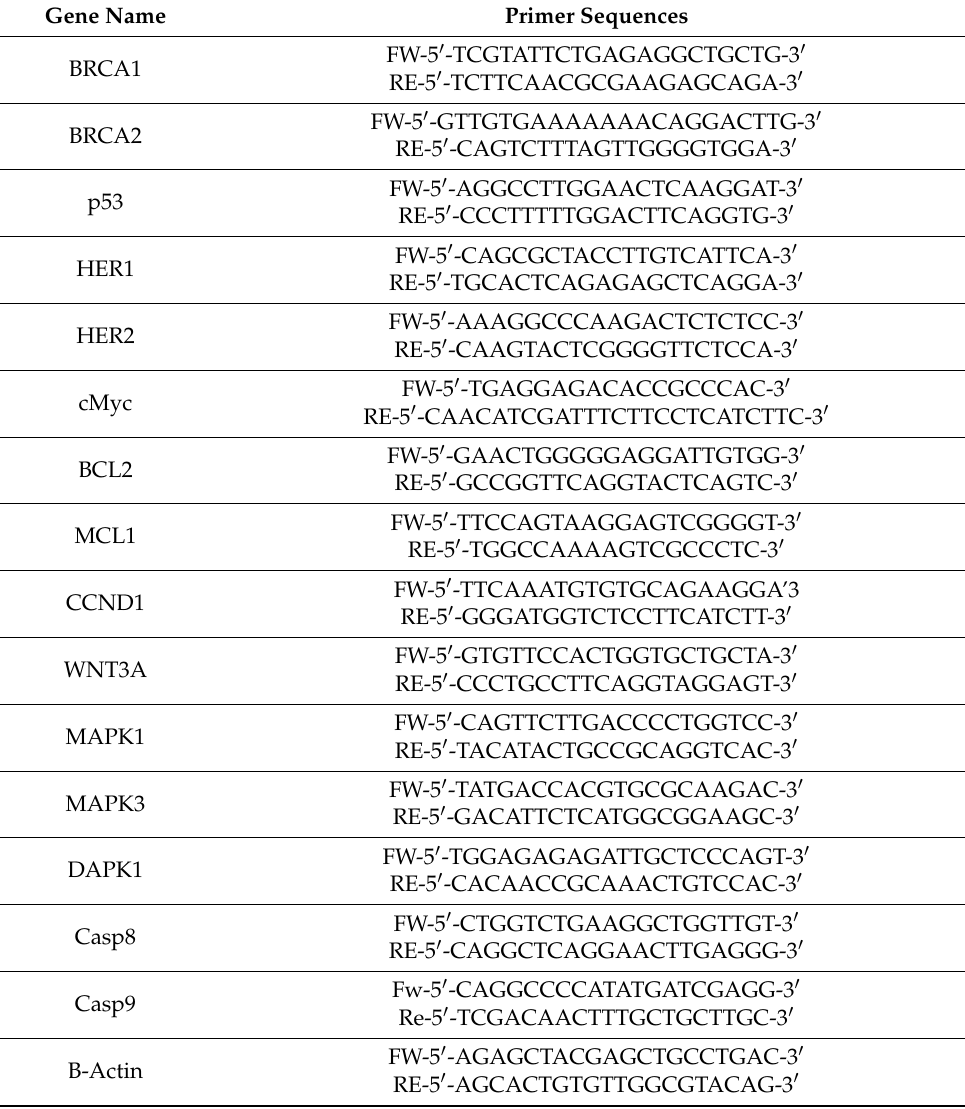
Table 1. Primers used in this